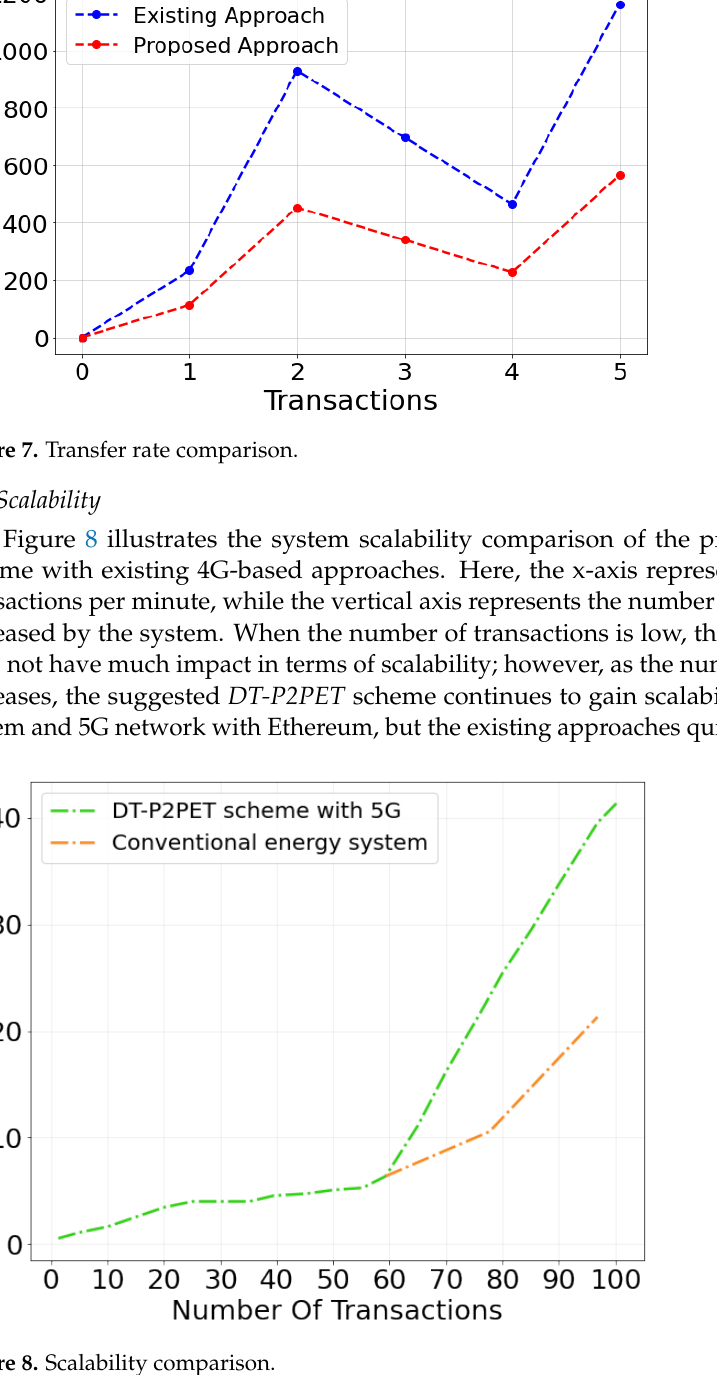
Figure 8. Scalability